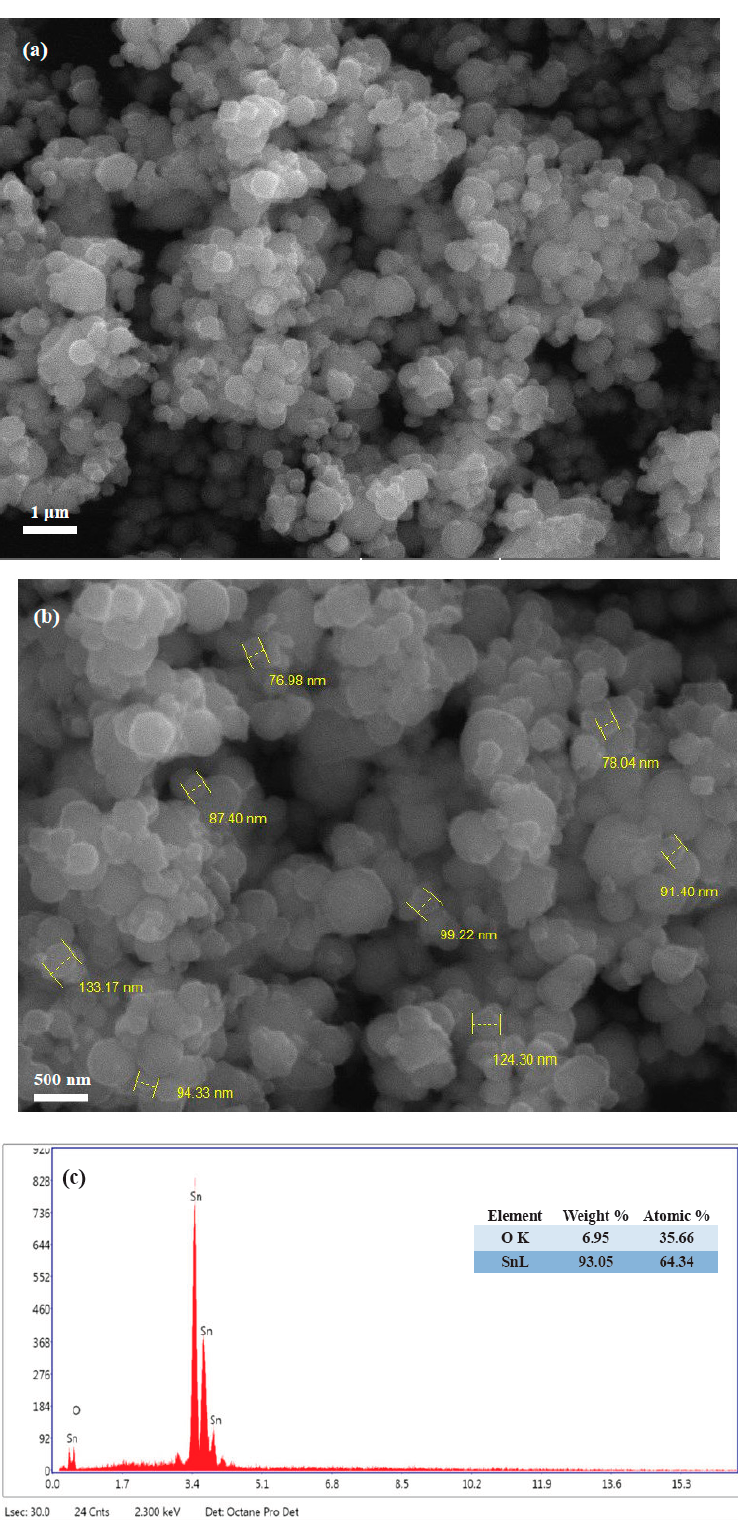
Figure 1. Scanning Electron Microscopy (SEM) imaging of prepared tin nanoparticles (SnNPs) at different resolutions: ( a ) 100 μ m ( b ) 500 nm, and (c) Energy-Dispersive X-ray (EDX) spectra.